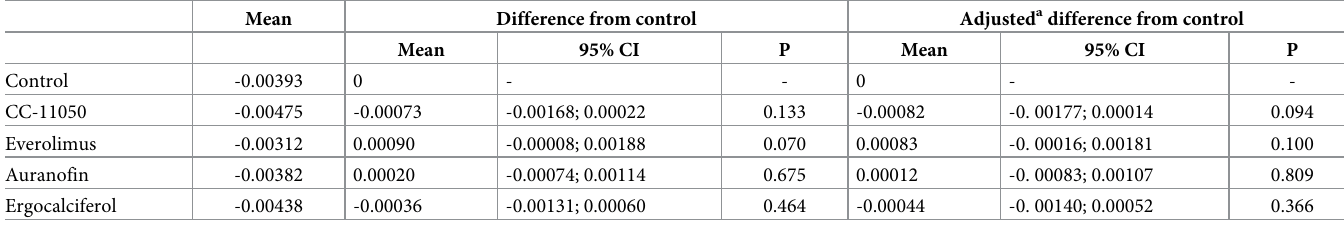
Table 4. Effects on log-log CRP slope throughout